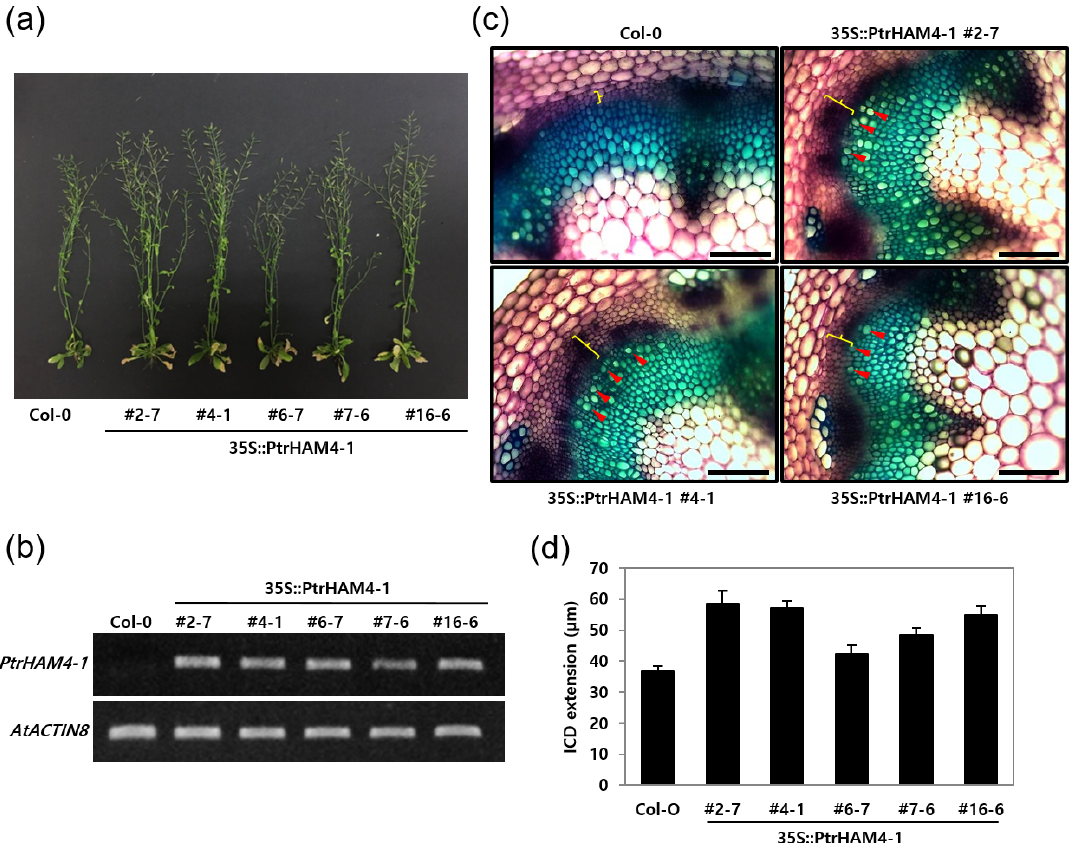
Figure 7. Overexpression of PtrHAM4-1 in transgenic Arabidopsis increased cambium development. ( a ) Overall growth phenotypes of transgenic Arabidopsis plants. Five independent T3 homozygote transgenic lines (e.g., 2–7, 4–1, 6–7, 7–6, and 16–6) are shown. ( b ) Expression of the PtrHAM4-1 gene in the independent transgenic Arabidopsis lines compared with Col-0. First-strand cDNA was synthesized from the total RNA extracted from stem tissues and used as a template in semi-quantitative RT-PCR experiments. ( c ) Observation of cambium development in stem cross sections from 60-day-old transgenic Arabidopsis and Col-0. Yellow braces indicate the ICD (interfascicular cambium-derived tissue) extension and red arrowheads point to secondary xylem vessels within the interfascicular region. Scale bars represent 100 μ m. ( d ) Quantification of ICD extension in 60-day-old transgenic Arabidopsis plants compared to Col-0. ICD extensions were measured in all interfascicular regions of rosette level stem sections from five independent transgenic lines. Error bars indicate S.E. ( n = 5).